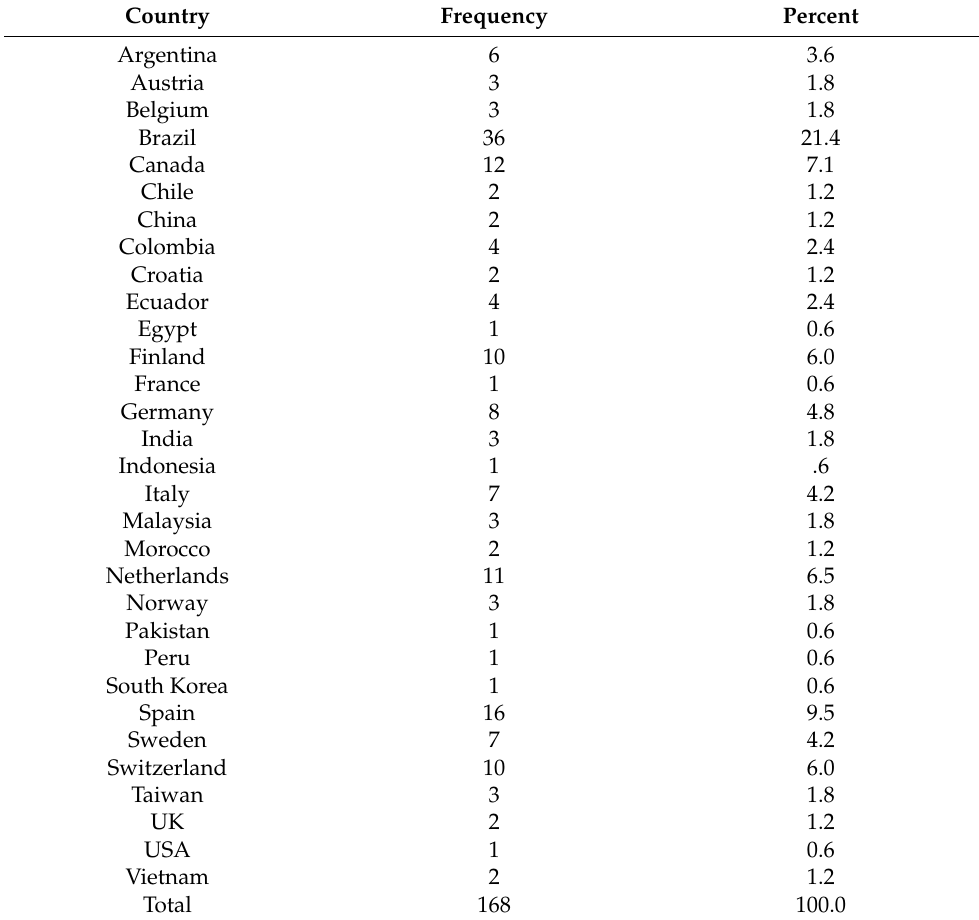
Table 3. Cooperative sustainability reports per